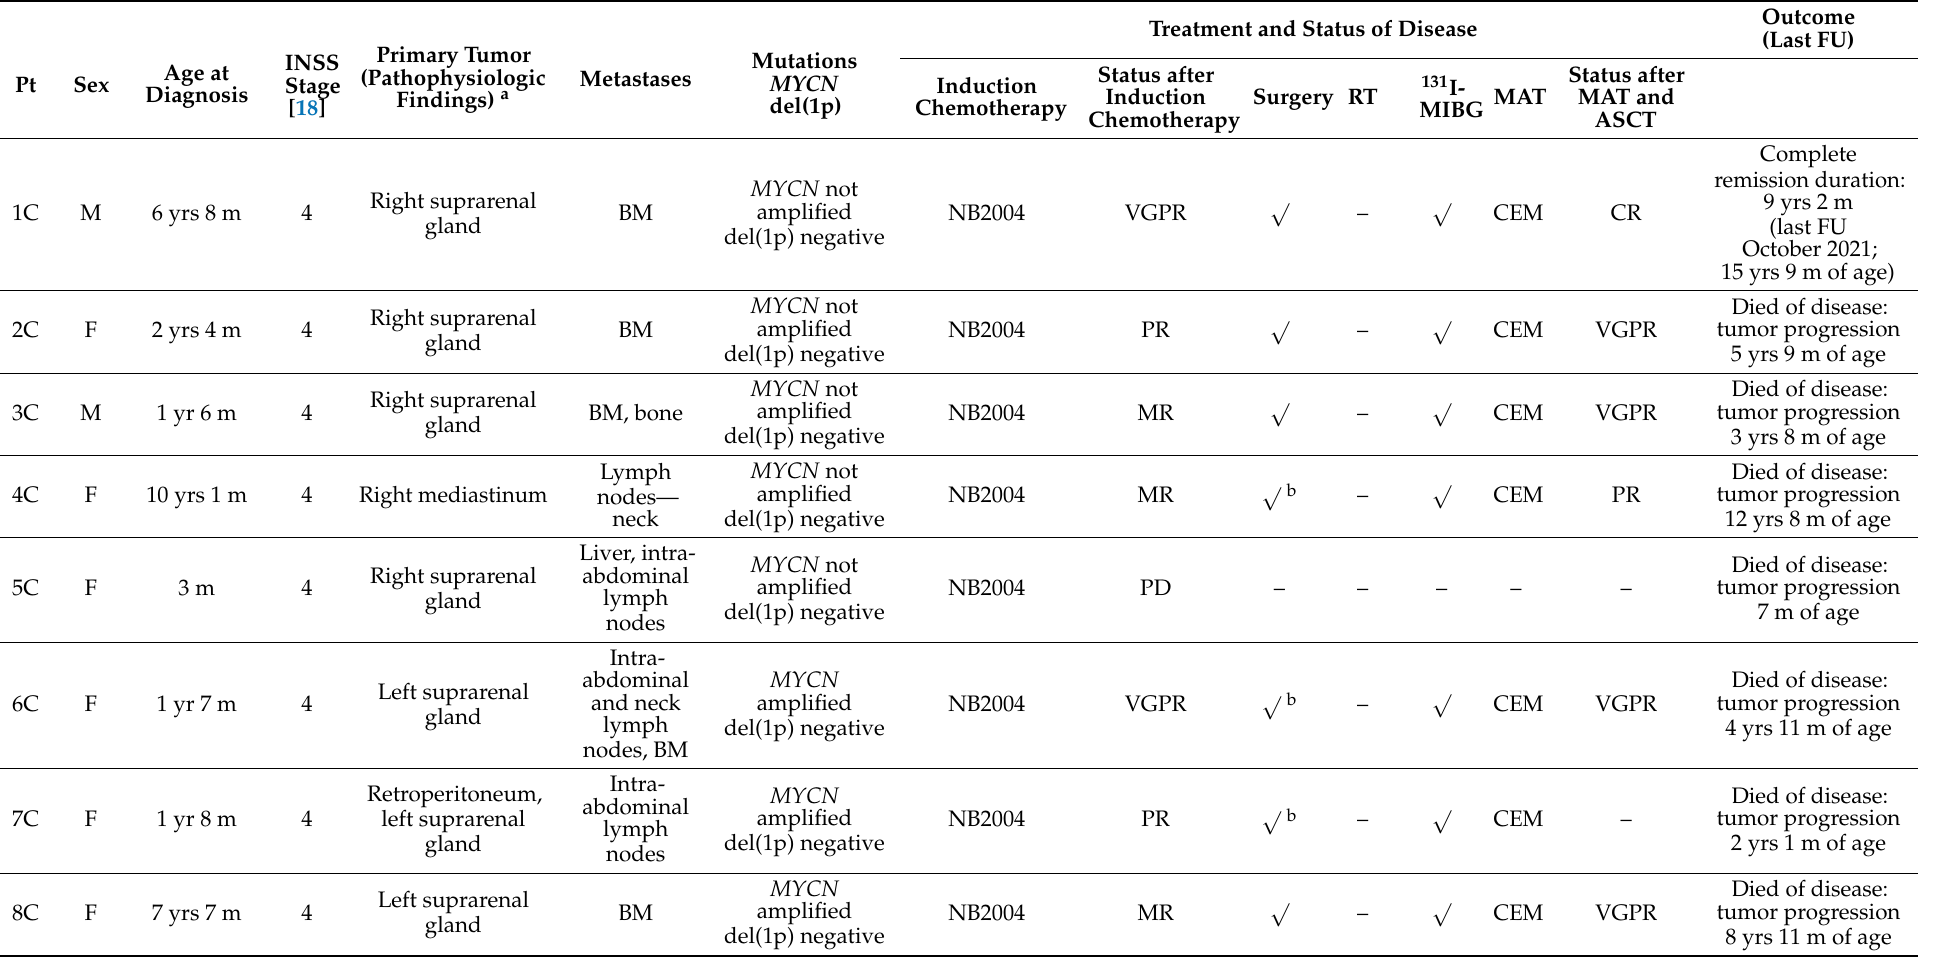
Table 2. Disease characteristics, treatment and outcomes for 12 patients with high-risk neuroblastoma who did not receive